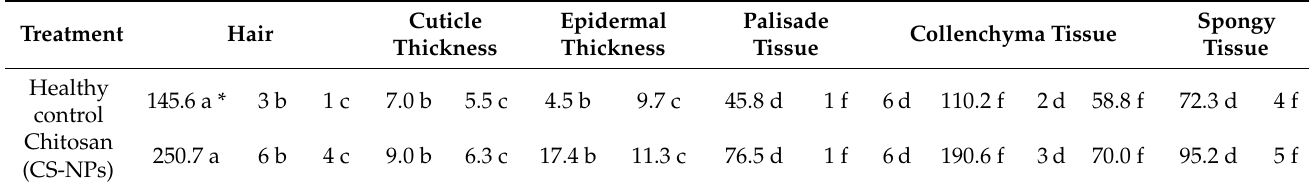
Table 2. Anatomical properties of potato leaves treated with chitosan (CS-NPs).